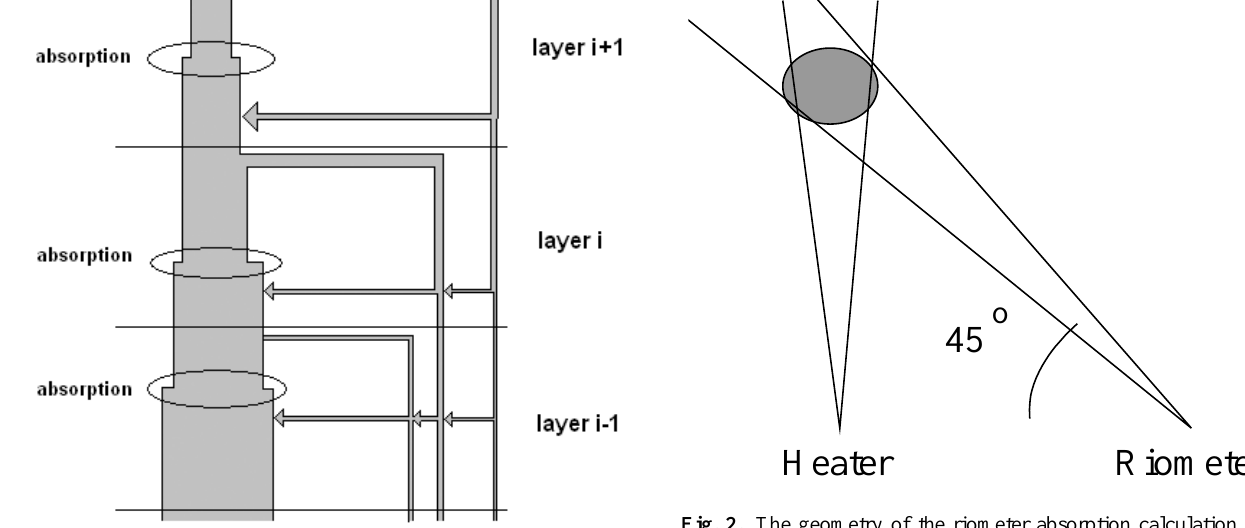
Fig. 2. The geometry of the riometer absorption calculation. An angle of 45 ◦ between the heater and riometer beams is assumed, corresponding approximately to beam 9 of the IRIS riometer in Kilpisj¨arvi. We assume a perfect